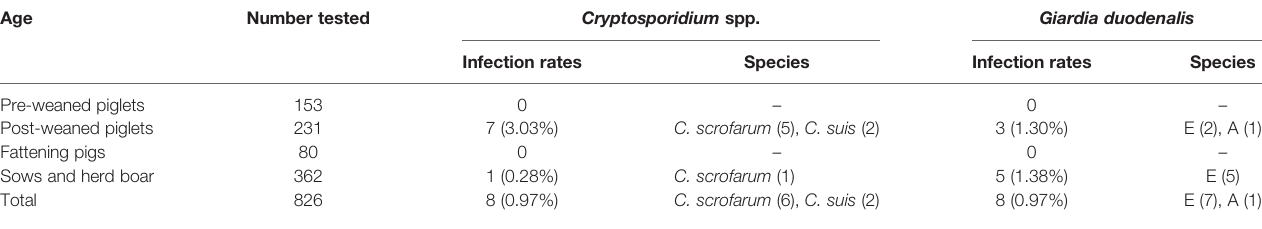
TABLE 2 | Prevalence and genetic characterizations of Cryptosporidium spp. and Giardia duodenalis arranged by age group in pigs in Hubei of China. Age Number tested Cryptosporidium